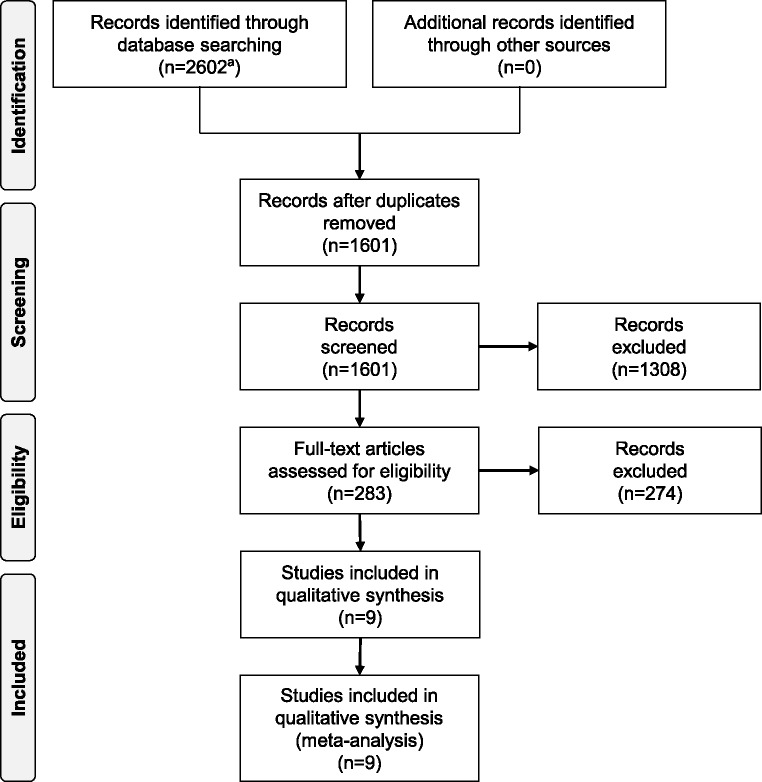
PRISMA flow diagram.aWe identified 823 records in Pubmed, 728 in Web of Science, and 1052 in EMBASE.